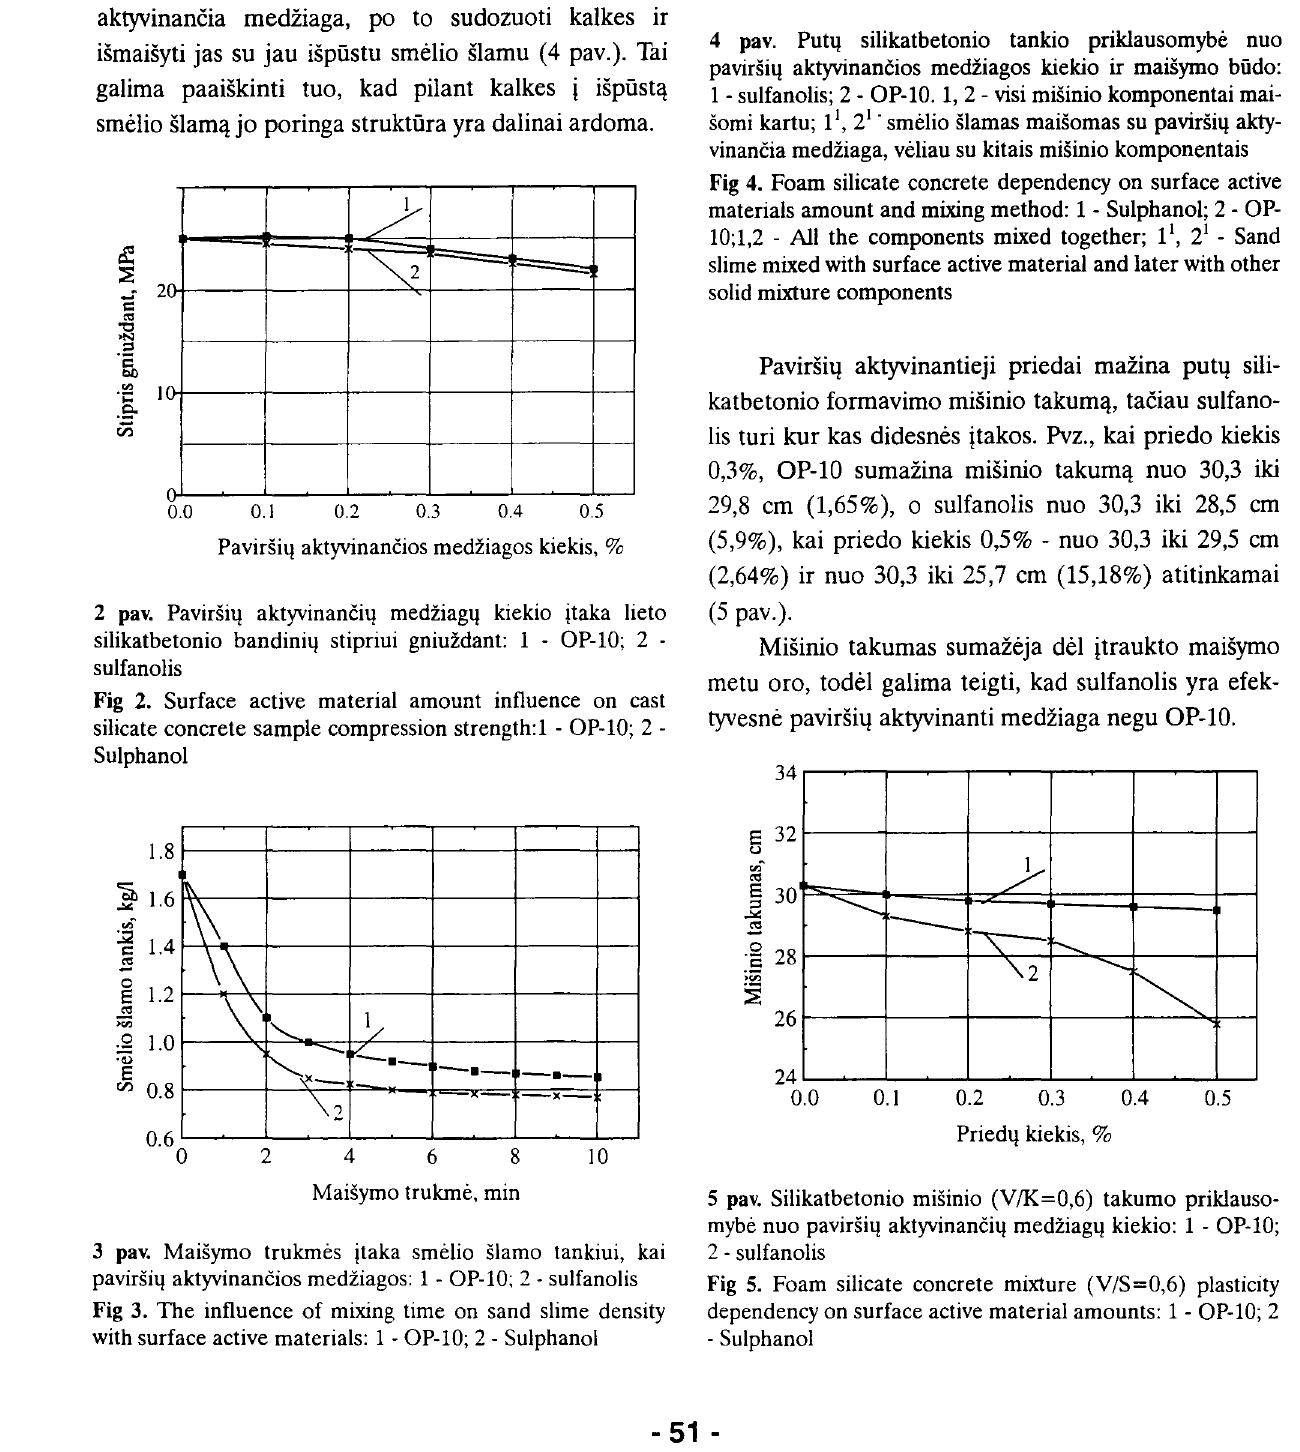
Fig 5. Foam silicate concrete mixture (V/S=0,6) plasticity dependency on surface active material amounts: 1- OP-10;